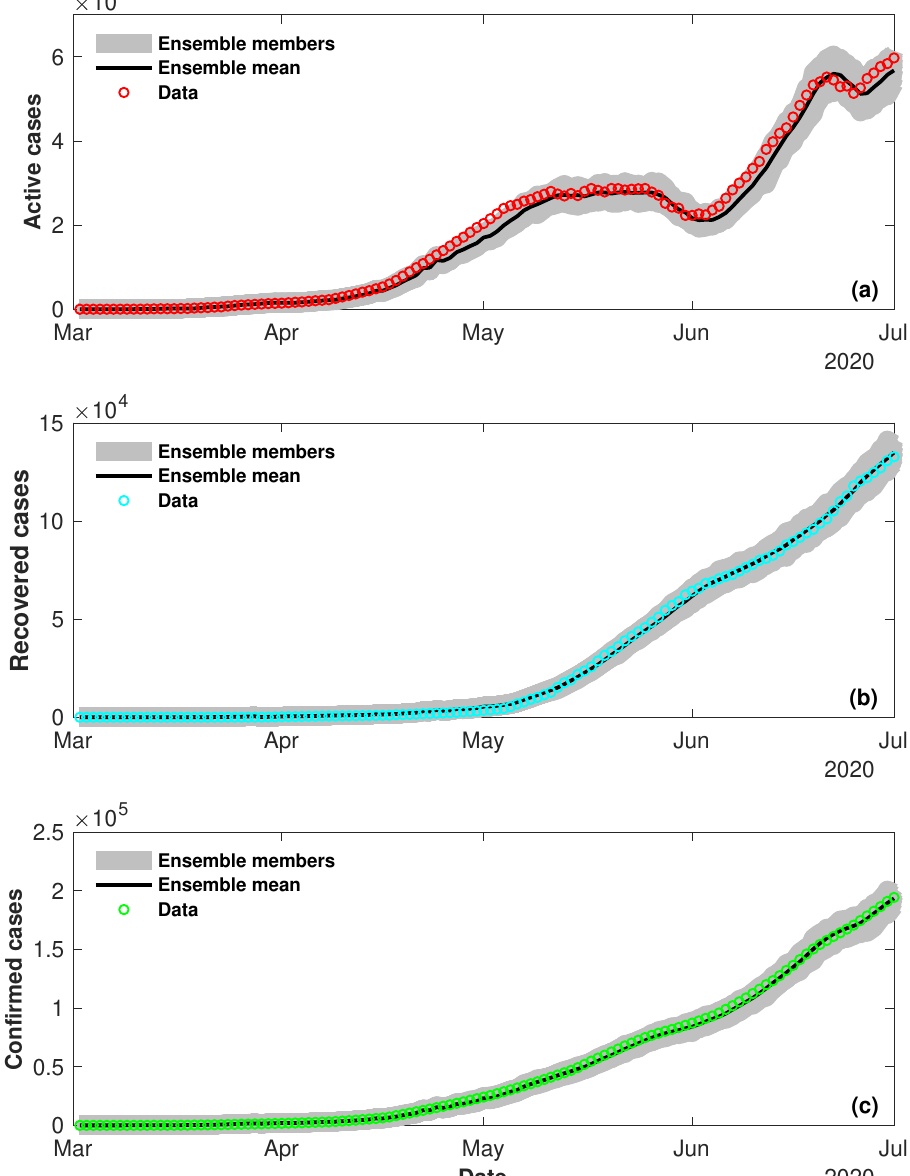
Figure 3. Assimilated numbers of: ( a ) Active cases. ( b ) Recovered cases. ( c ) Confirmed